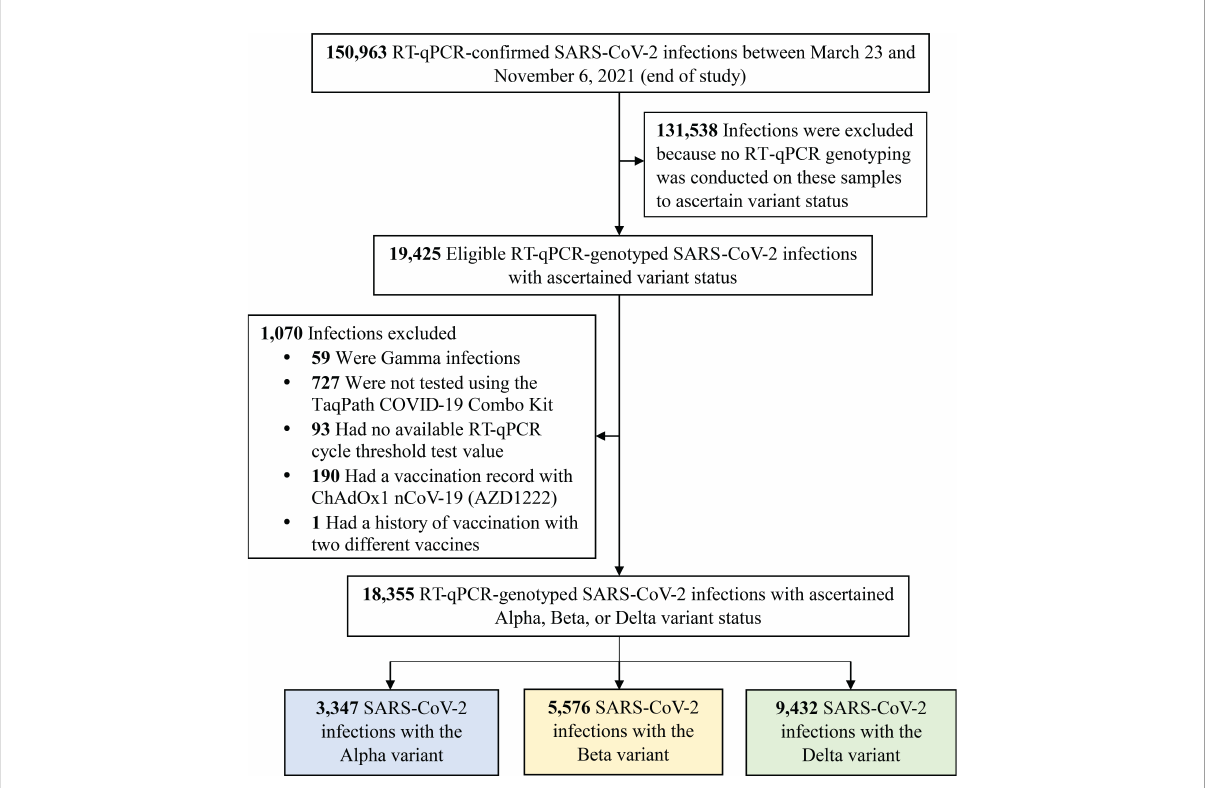
FIGURE 1 Flowchart describing the population selection process for investigating infectiousness of SARS-CoV-2 Alpha, Beta and Delta infections. Abbreviations: COVID-19, coronavirus disease 2019; RT-qPCR, real-time reverse-transcription polymerase chain reaction; SARS-CoV-2, severe acute respiratory syndrome coronavirus